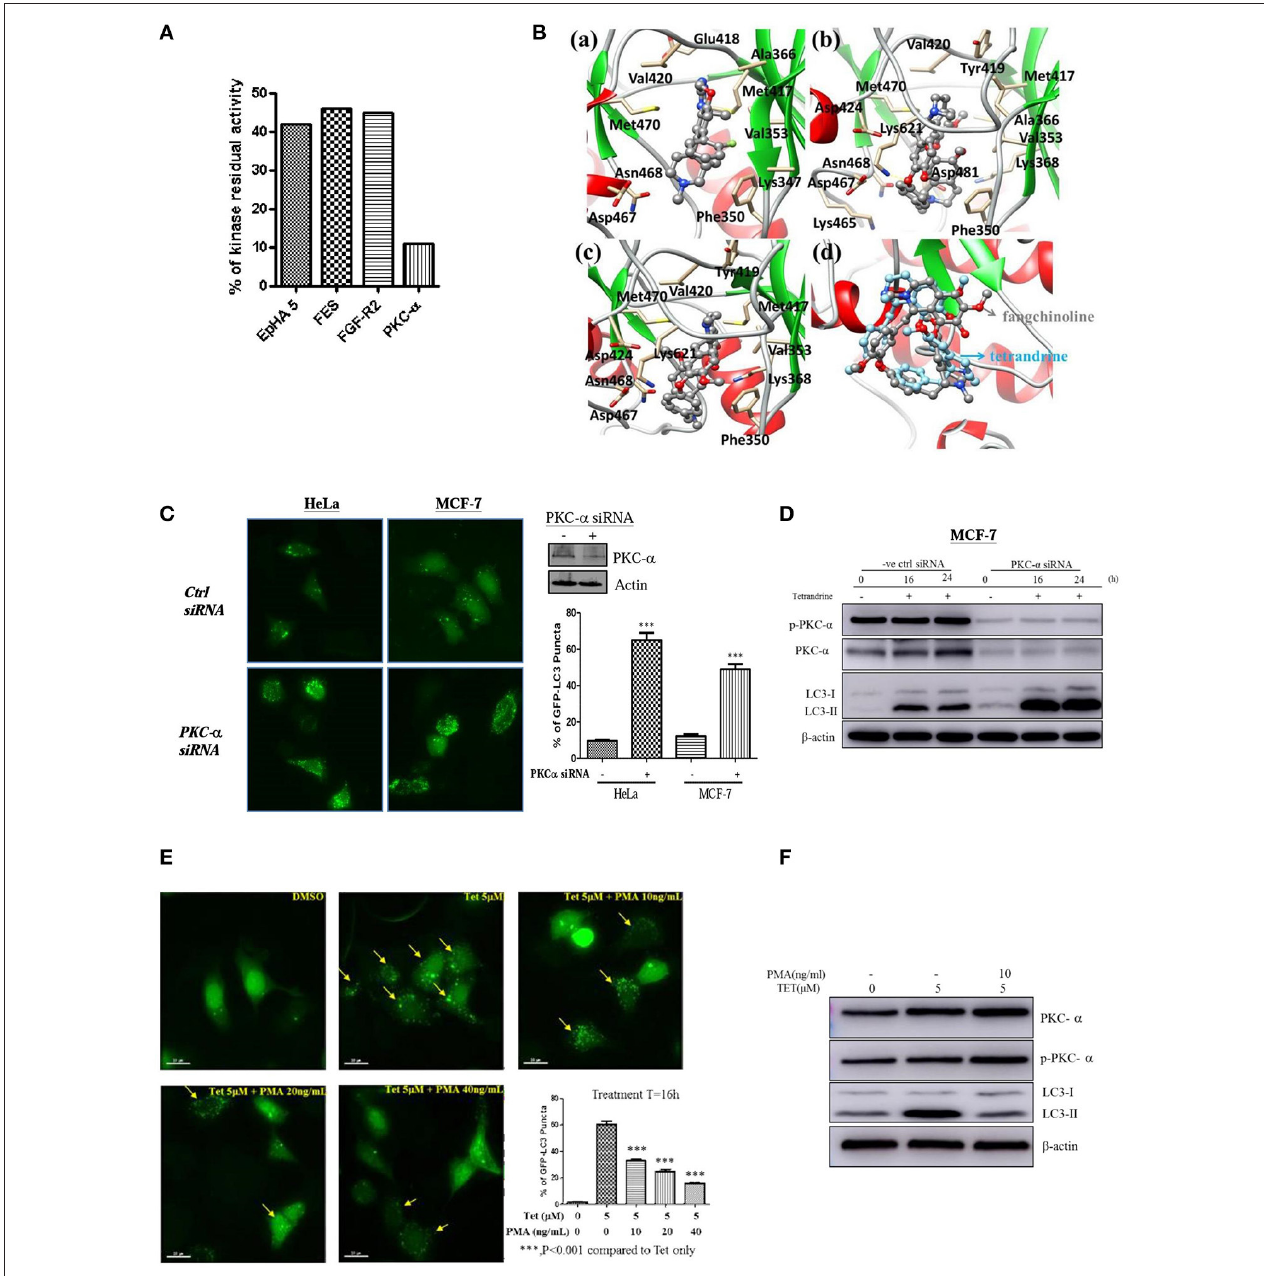
FIGURE 4 | Tetrandrine induces autophagy through PKC- α inhibition. (A) Kinase inhibition profile of Tet was determined by measuring the residual activity values of 300 wild-type protein kinases. Bar chart represents the identification of the kinases whose residual activity dropped below 50% when treated with 1 µ M of tetrandrine. Receptor tyrosine kinase (EpHA5), protein-tyrosine kinase (FES), fibroblast growth factor receptor 2 (FGFR2) and PKC- α with residual activity dropped below 50% were shown. (B) The binding modes of (a) compound 28, (b) tetrandrine, or (c) fangchinoline with PKC- α , and (d) the aligned conformations of tetrandrine and fangchinoline in complex with PKC- α . (C) HeLa and MCF-7 cells were transfected with control negative siRNA sequence or PKC- α -siRNA together with GFP-LC3 plasmid for 24 h; cells were then fixed for fluorescence microscopic analysis, and (D) western blot analysis for targeting PKC- α , p-PKC- α and LC3-II in MCF-7 cells, respectively. Bar chart represents the percentage of cells with GFP-LC3 puncta formation. (E) MCF-7 cells transiently transfected with the GFP-LC3 plasmid for 24 h were treated with DMSO (Ctrl) or 5 µ M of Tet in the presence or absence of PKC- α activator, PMA, with the indicated concentrations for 16 h. Arrows indicated cells with GFP-LC3 puncta formation. Bar chart represents the percentage cells with GFP-LC3 puncta formation. Columns, means of three independent experiments; bars, SEM. *** p < 0.001. (F) MCF-7 cells were treated with DMSO (Ctrl) or 5 µ M Tet in the presence or absence of PMA (10 ng/ml), for 16 h before subjecting to western blot